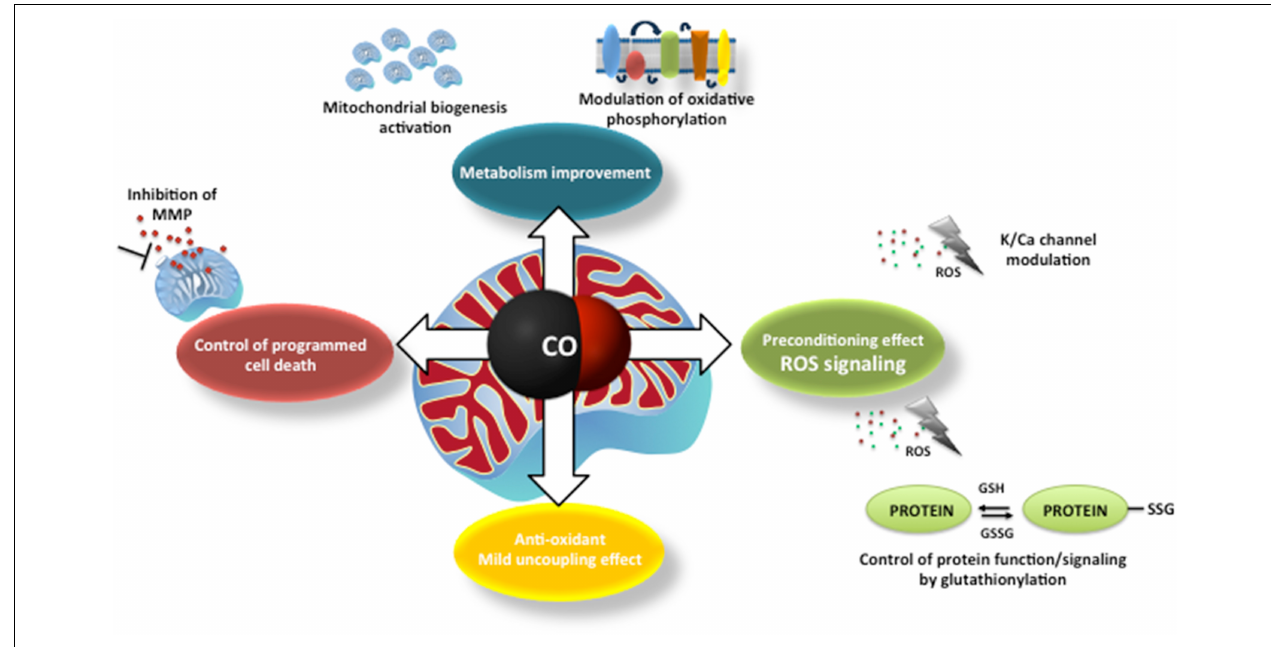
FIGURE 1 | The main described mechanisms of carbon monoxide on mitochondria: modulation of mitochondrial membrane permeabilization and cell death control; improvement of mitochondrial metabolism